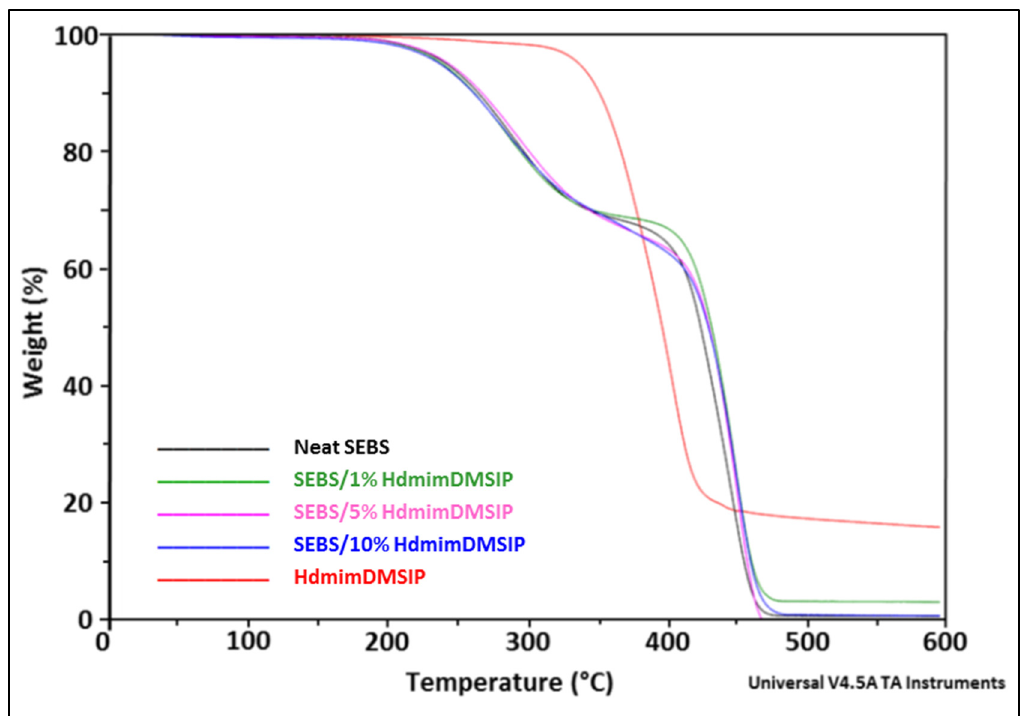
Figure 5. TGA curves of the IL HdmimDMSIP, neat SEBS, and SEBS/IL blends.